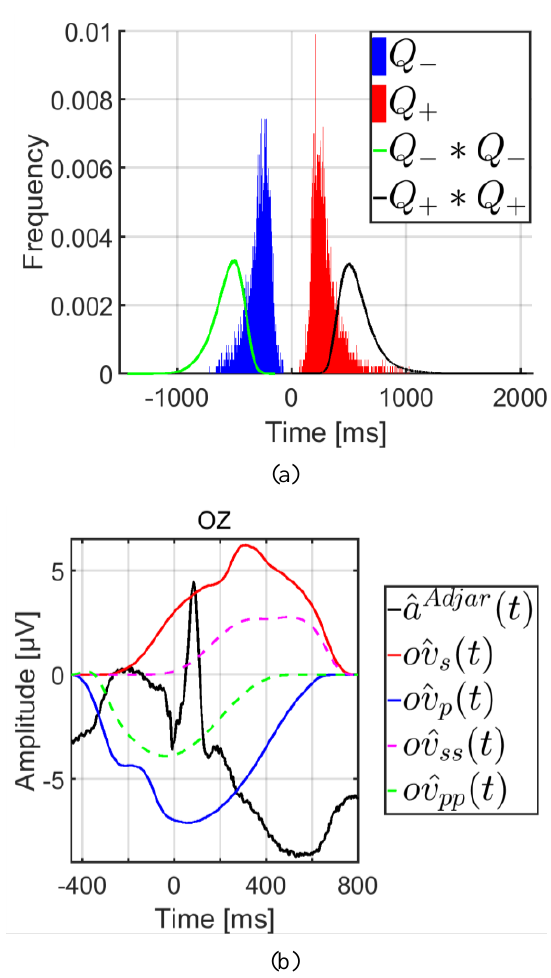
Figure 1 (a) Normalized distributions 𝑄 −1 (𝑡) , 𝑄 +1 (𝑡) and the envelope of these distributions after convolutions: 𝑄 −1 (𝑡) ∗ 𝑄 −1 (𝑡) , 𝑄 +1 (𝑡) ∗ 𝑄 +1 (𝑡) ; (b) evoked potential estimated by the ADJAR algorithm ( 𝑎̂ 𝐴𝑑𝑗𝑎𝑟 (𝑡) ), the first-order ( 𝑜𝑣̂ 𝑝 (𝑡) , 𝑜𝑣̂ 𝑠 (𝑡) ) and second-order ( 𝑜𝑣̂ 𝑝𝑝 (𝑡) , 𝑜𝑣̂ 𝑠𝑠 (𝑡) ) response overlaps on Oz electrode, at